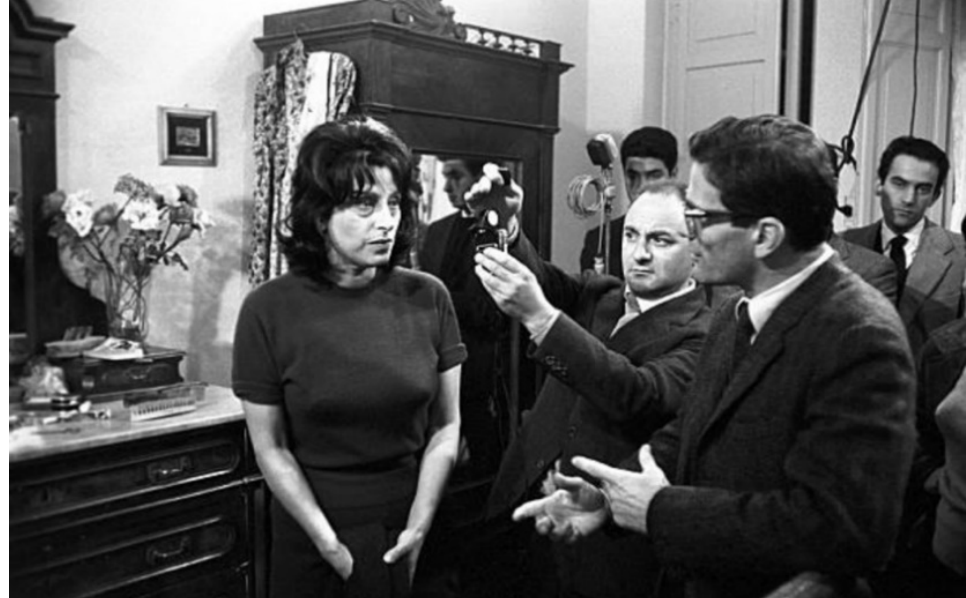
Figure 5. Italian actress Anna Magnani discussing with Italian director, writer and poet Pier Paolo Pasolini on the set of the film Mamma Roma. Rome, 1962. Photograph by Angelo Novi. Credits: Mondadori Portfolio via Getty Images .